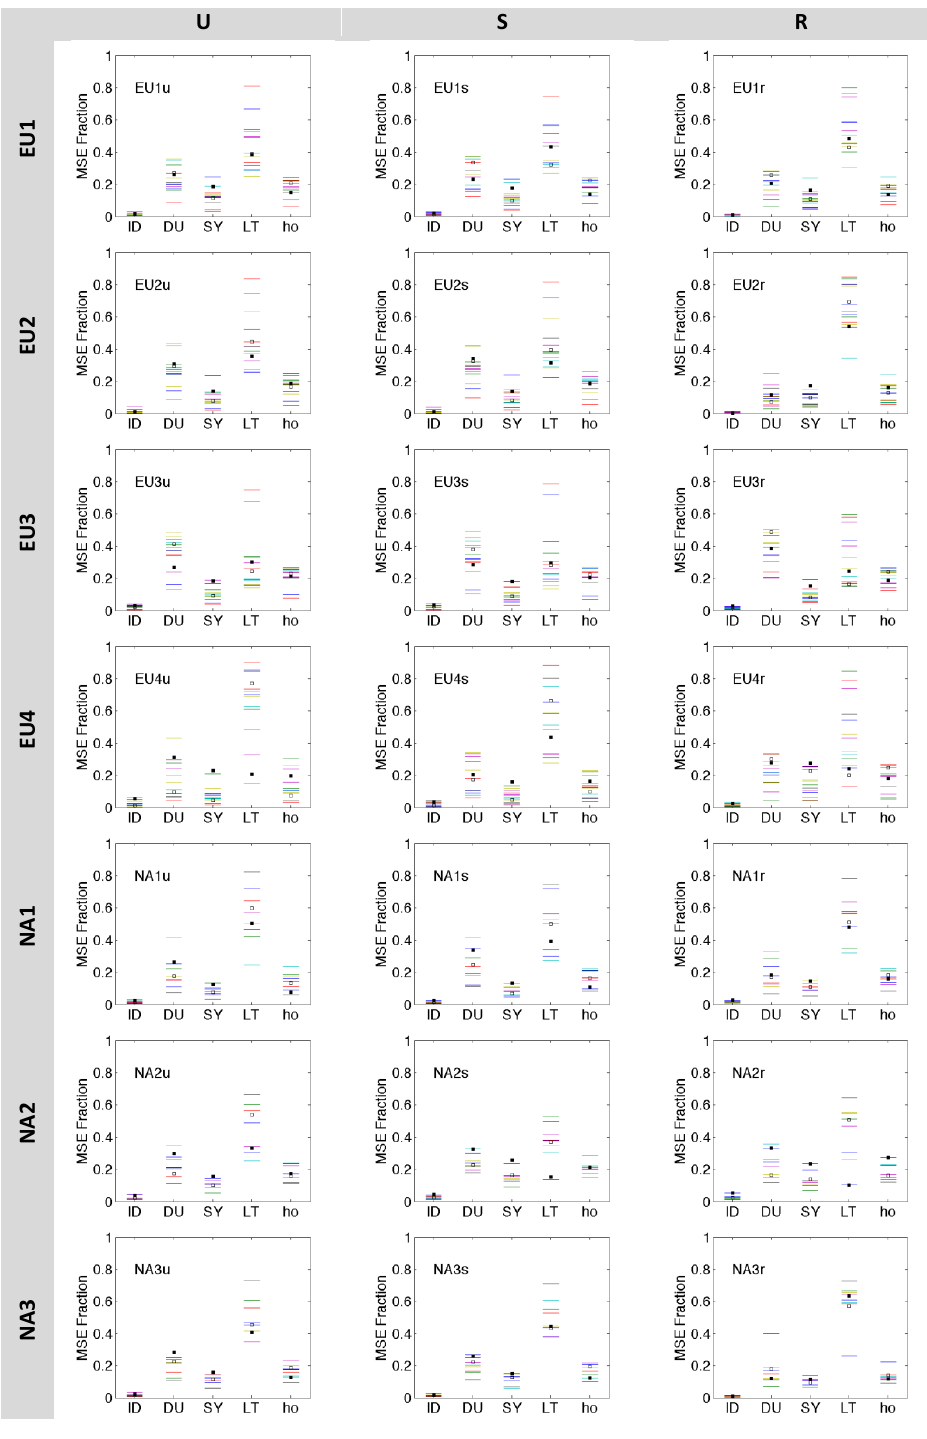
Fig. 7d. Properties of the spectrally decomposed modelled time-series of ozone, into four (ID, DU, SY, LT) components, versus their observed counterparts. Results are shown for all seven subdomains and three ozone aggregation types. For all plots, the square marker reflects the mm, the filled square the kz, the red circle the observations and the coloured lines the individual models. (d) MSE fraction: the decomposition of the mean square error of the modelled time-series in terms of the fraction each of the four spectral components accounted for. For mm, LT represents the principal error driver followed by DU (only exception is EU3). Using optimal components, kz has more balanced error